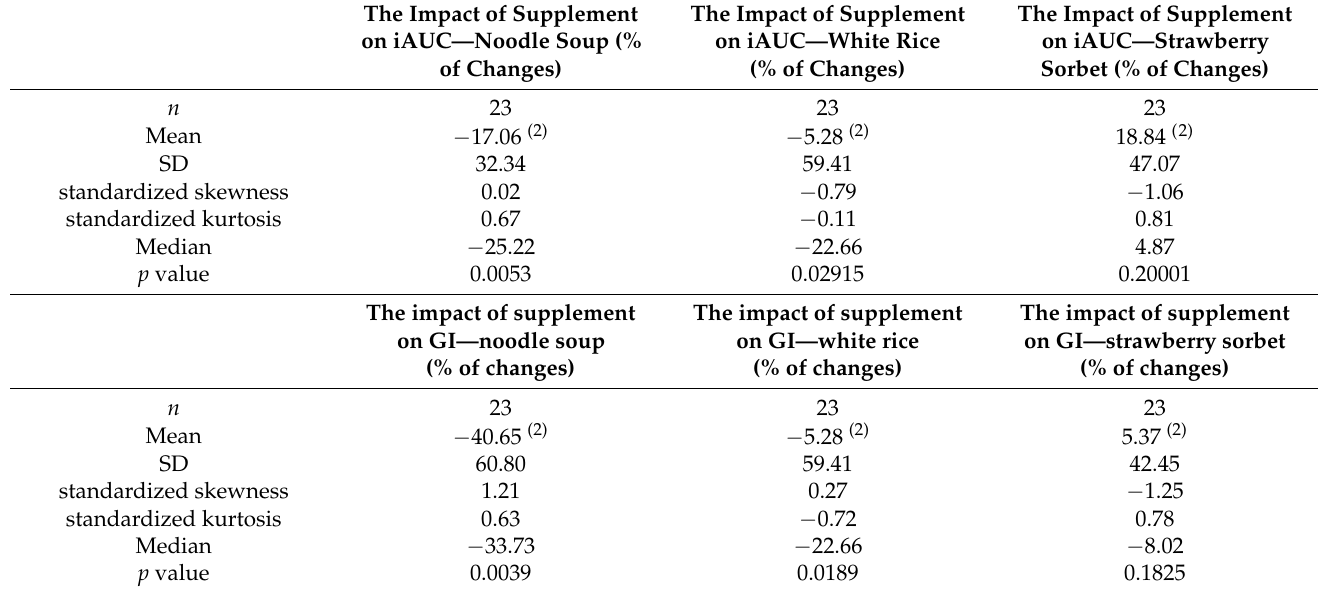
Table 6. The effect of the addition of the plant-based formula on glycemia and GI values (1) . The Impact of Supplement The Impact of Supplement The Impact of Supplement on iAUC—Strawberry on iAUC—White Rice on iAUC—Noodle Soup (% Sorbet (% of (% of Changes) of Changes)